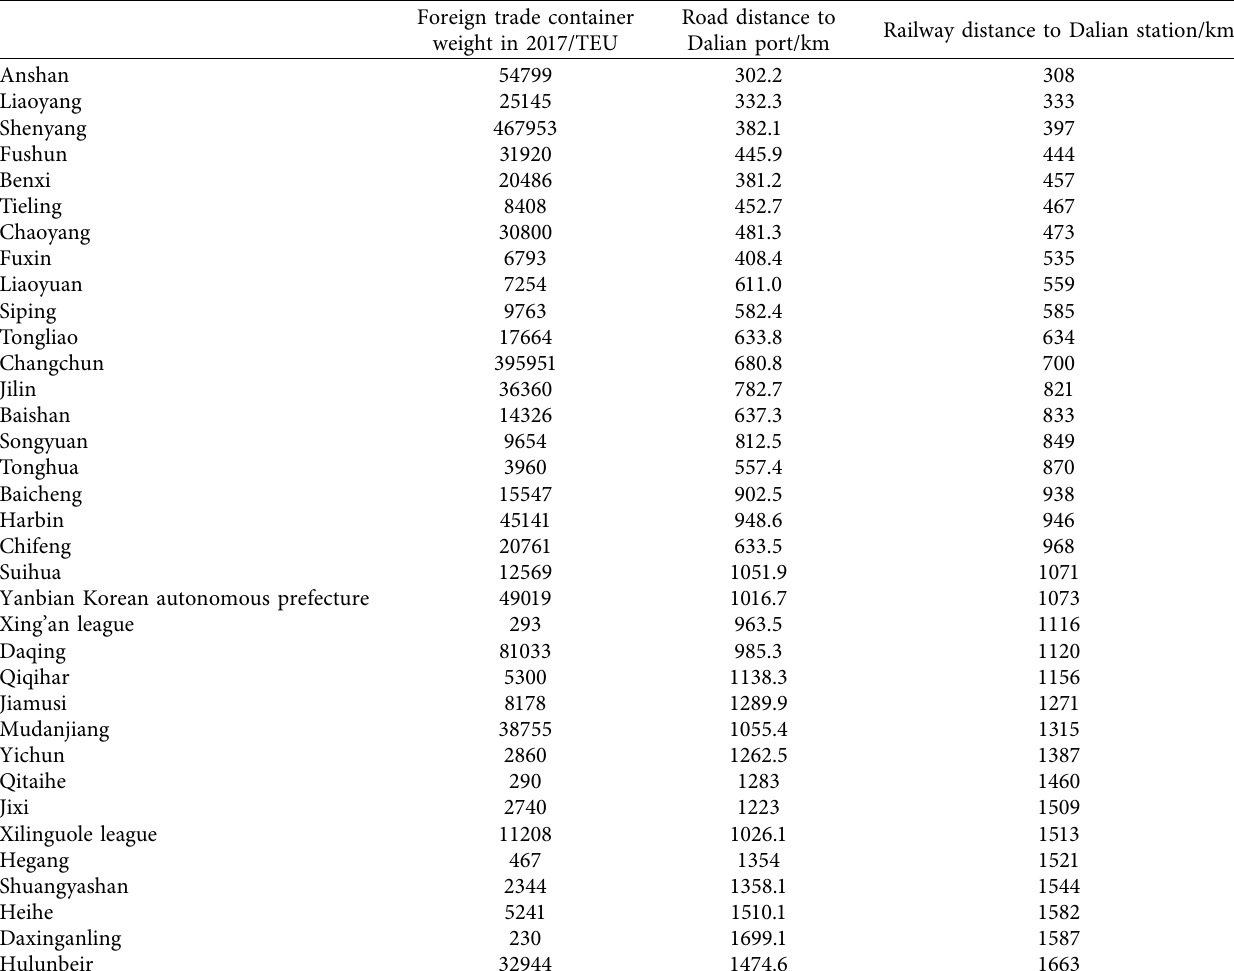
Table 4: Foreign trade container volume and related mileage data of